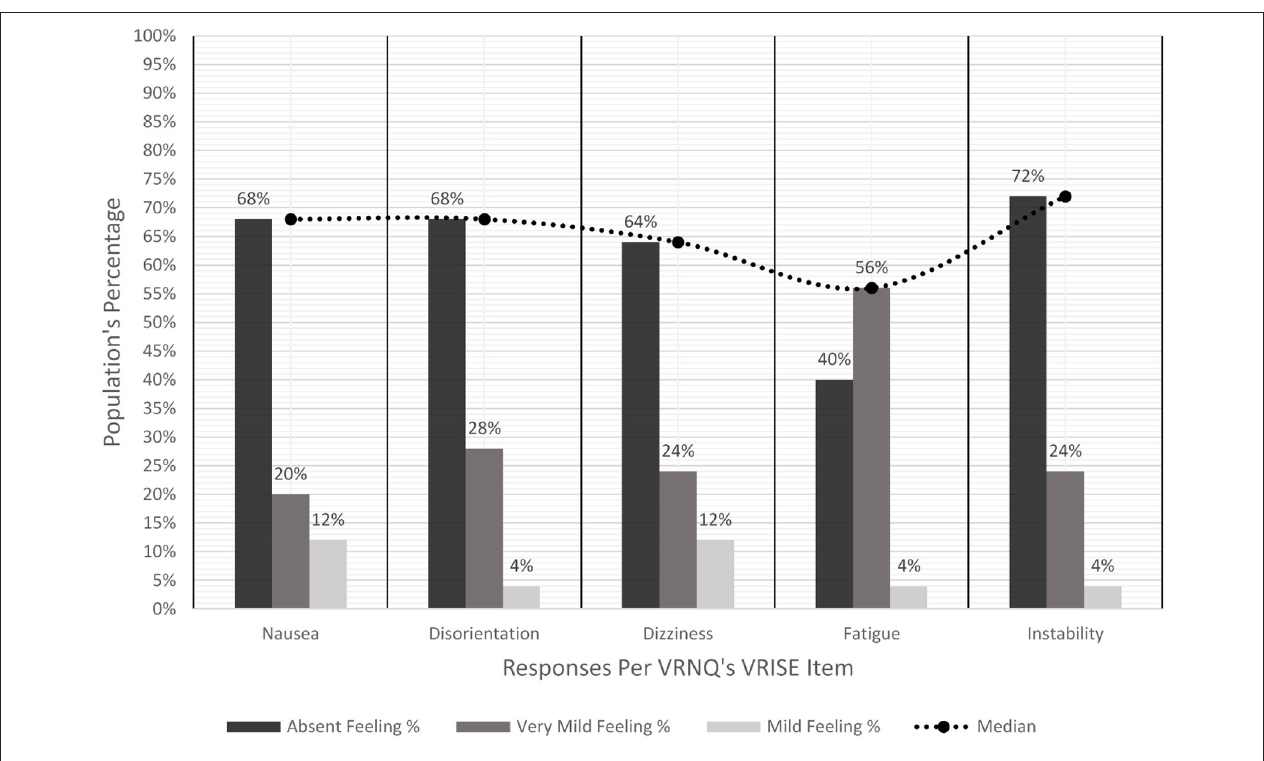
FIGURE 8 | VRISE in the final version of